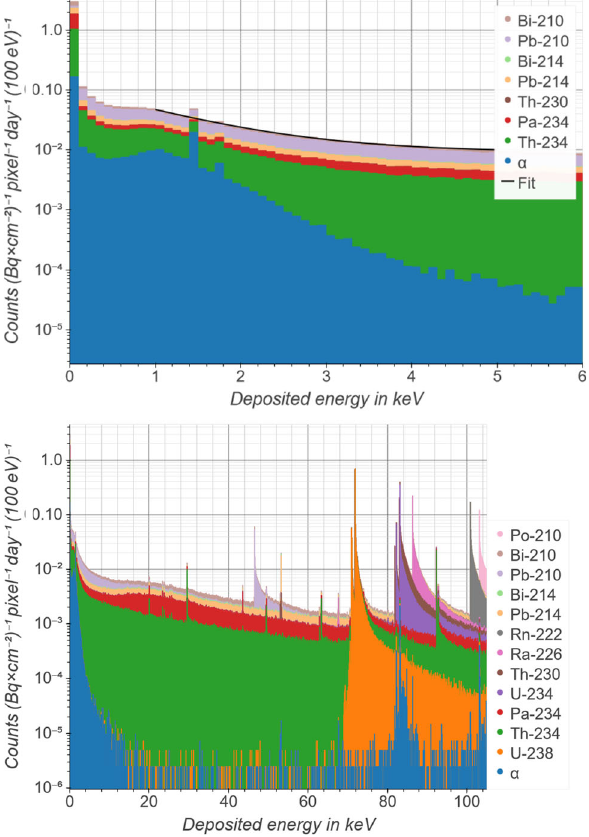
Fig. 4 Simulated spectrum of deposited energies in the MMC absorbers caused by the bulk-distributed 238 U-chain. The fractions due to the single nuclides of this chain are colored. The summed spectrum is structure-less for low energies. Nuclides decaying by an α -decay change the spectrum only minor at low energies, exemplary shown for 238 U. However, α -particles can escape the absorber and hit the alu- minum shielding or the substrate. Thus, aluminum K X-ray and Auger electrons and silicon (substrate) K X-ray and Auger electrons as well